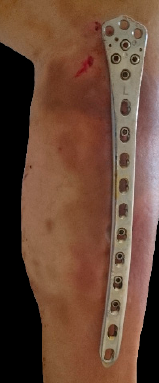
Figure 3. Postoperative photos of patients with a proximal ( left ) and a distal ( right ) meta-diaphyseal fracture fixed via externalized locked plating using either an ipsilateral reversed or a contralateral non-reversed LISS-DF plate, respectively.